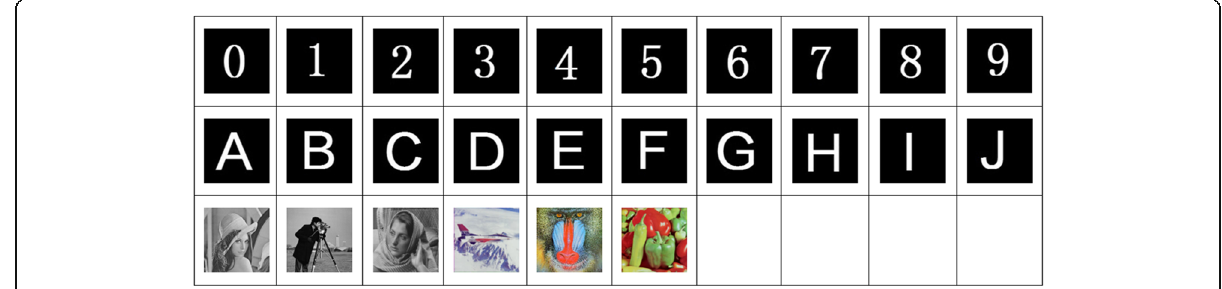
Fig. 7 Binary images, gray-level images, and color images used as test images, each of size 64 × 64